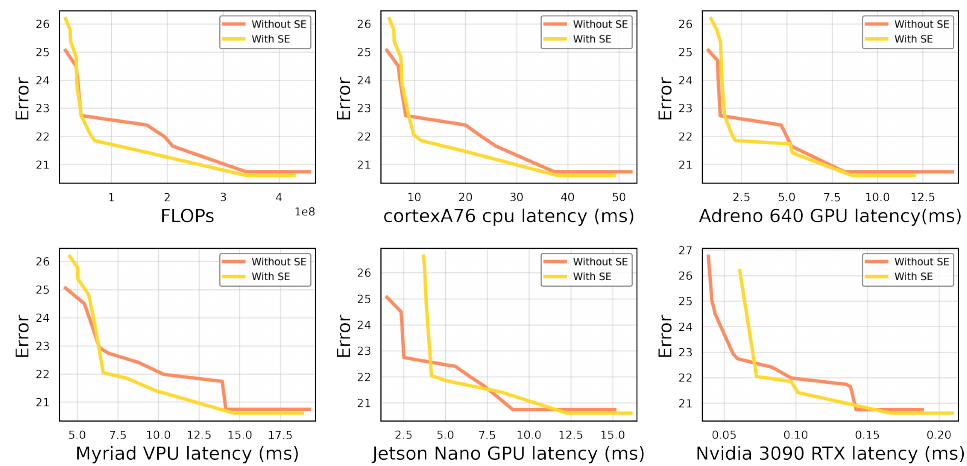
Figure 8. Adding a squeeze-and-excitation block improves performance on most hardware platforms but not all. The Jetson Nano GPU, for example, executes them significantly slower, making them not always the optimal